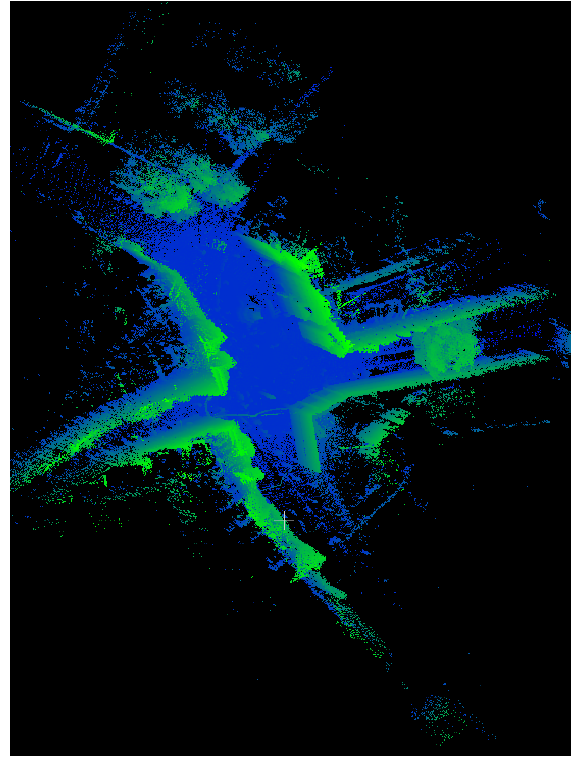
Figure 10. the twelve point clouds of Holzmarkt dataset after registration with height based